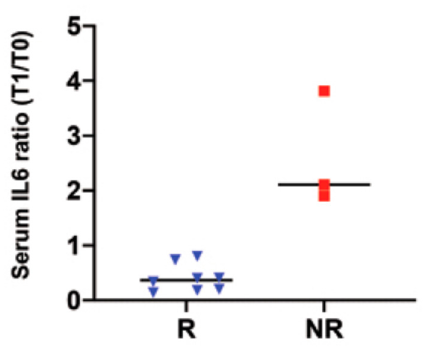
Figure 8. IL 6 ratio between the IL6 serum levels after 1 year of ECP treatment (T1)/baseline levels (T0) in the R and NR patients. The blue dots and red dots represent the responder (R) and non- responder (NR) patients, respectively.